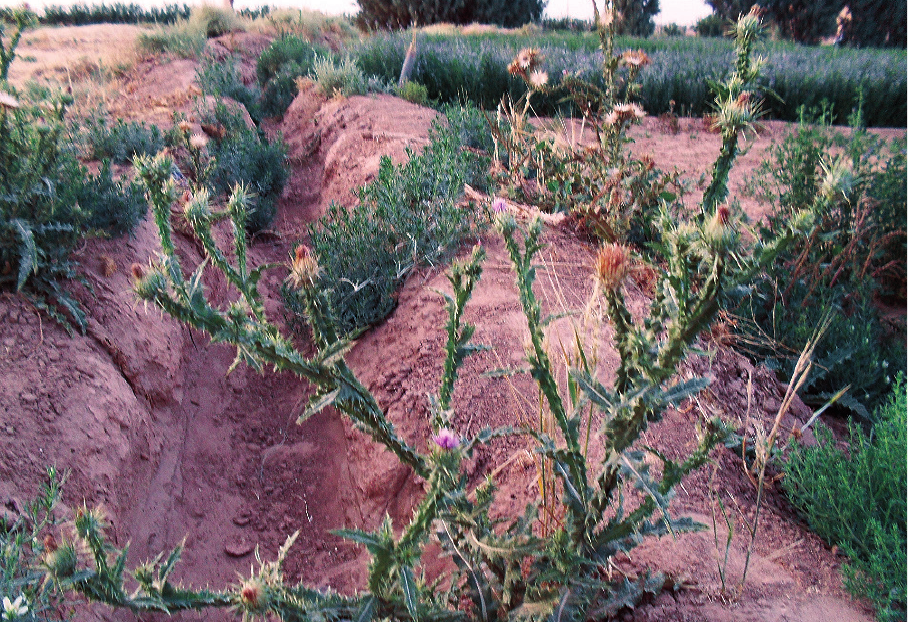
Figure 5. Onopordum acanthium L. host plant of Tephritis postica . Host plant. Flower heads of Onopordum acanthium L. (Fig. 5) from which the specimens were